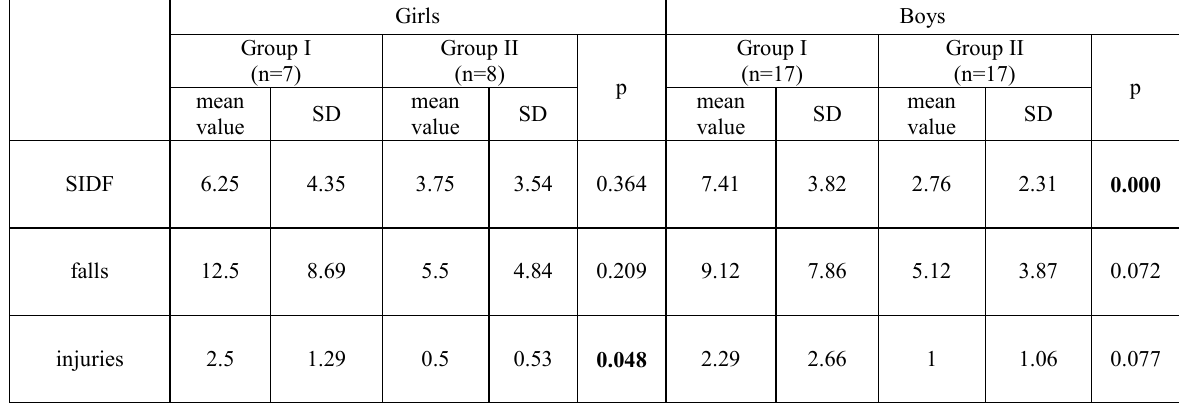
SIDF indicator value, the number of falls and injuries among the children aged 14-16 years